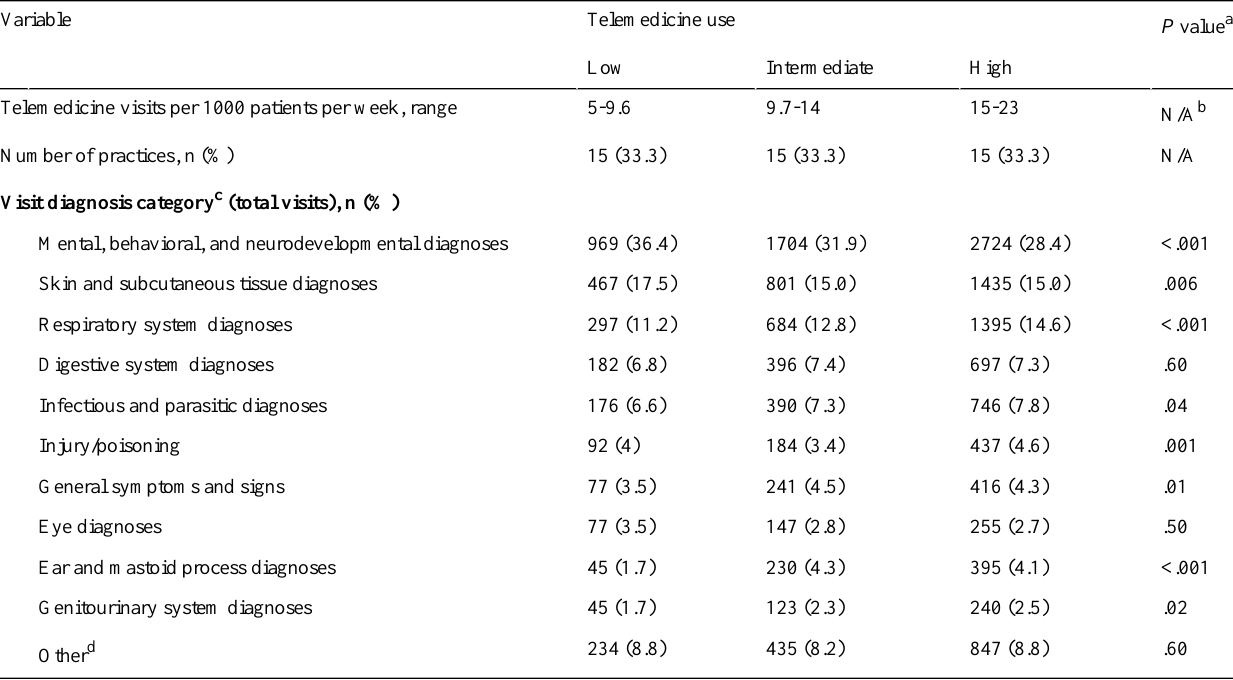
Table 2. Telemedicine visit diagnoses in practices (N=45) with low, intermediate, and high telemedicine use from March 18 to May 2, 2020.